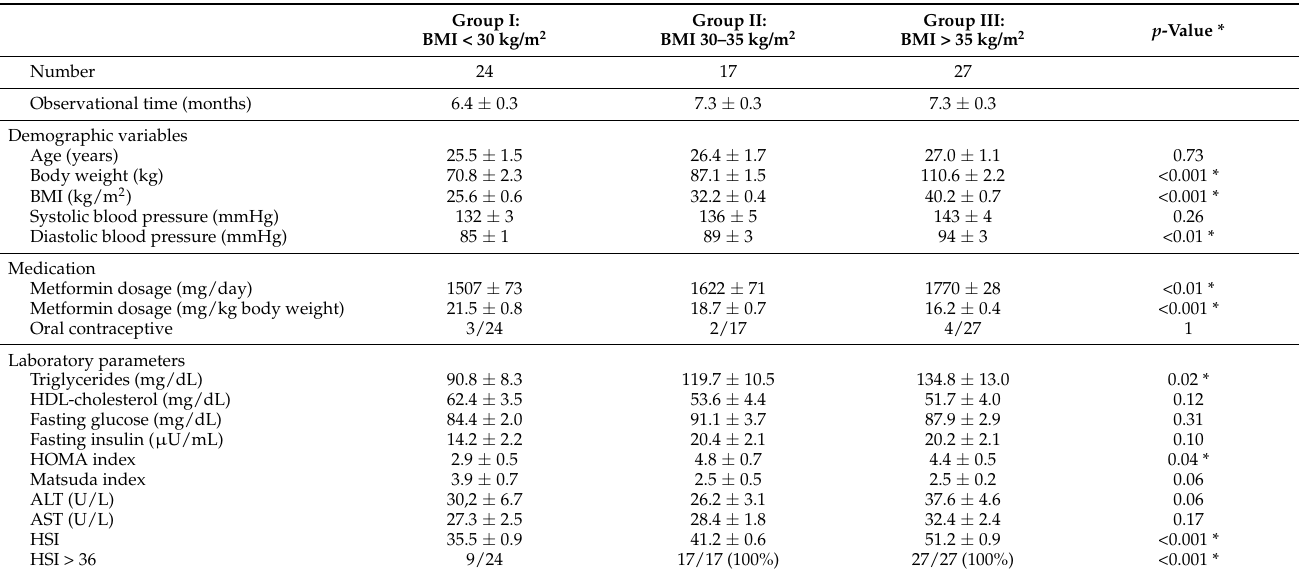
Table 2. Baseline characteristics of the patients in different BMI